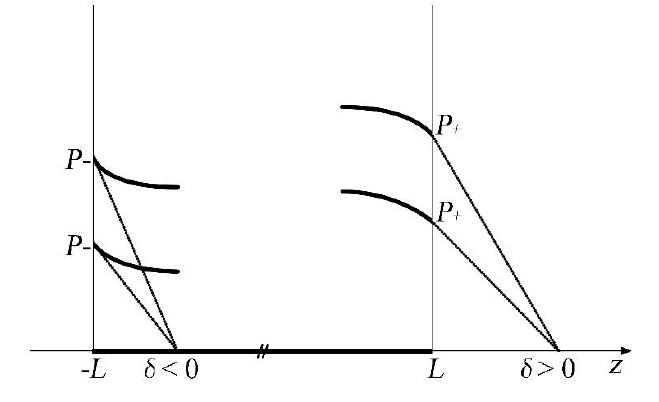
Figure 1. Surface polarization P + and P − corresponding to the extrapolation lengths δ > 0 and δ < 0 respectively. (Reproduced with permission from [133]; Copyright 2005,